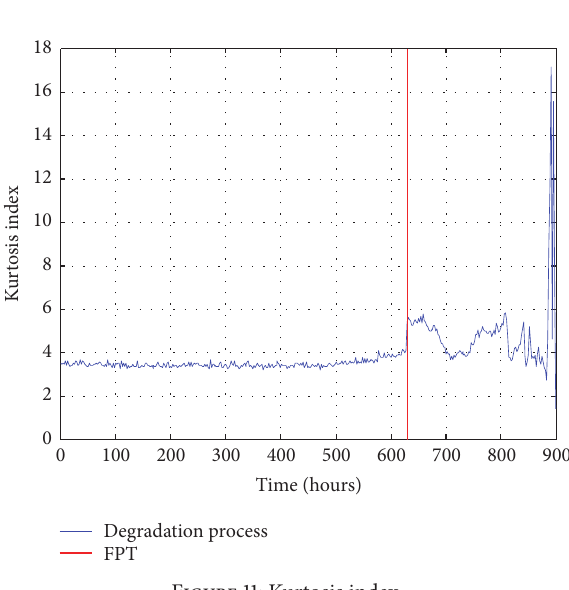
Figure 10: Waveform index.